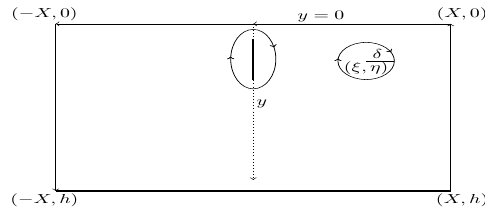
Figure 13. Contour for application of Green’s integral